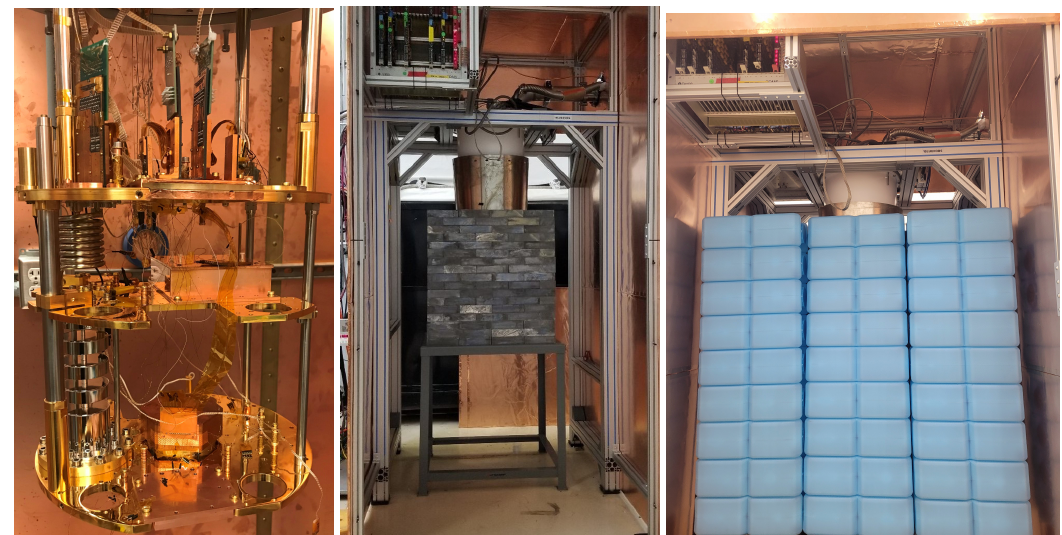
Figure 5: (left) Typical detector mounting inside the MINER Bluefors fridge, similar to how SuperCDMS test facilities mount the detectors. The SQUIDs are mounted at the 600 mK stage. The detector stack is designed to provide 1-inch internal hermetic shielding surrounding the detectors to reduce radioactive background, (center) 4- inch lead shielding surrounds the fridge with an open top, (right) 55% borated rub- ber sheets of 2mm thickness surround the lead shielding to capture thermal neutrons. Water bricks of 8-inch thickness surround the entire setup except for the open top. External neutrons are moderated by the water shielding and then captured efficiently by the borated rubber shielding, with the lead shielding providing shielding against external gammas and the gammas from the thermal neutron capture in